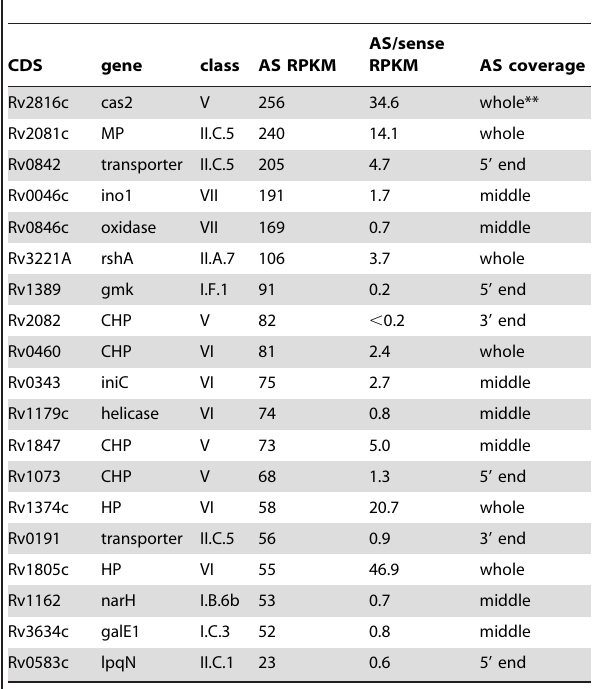
Ranking of most abundant antisense transcripts during exponential growth. **antisense transcript extends over multiple